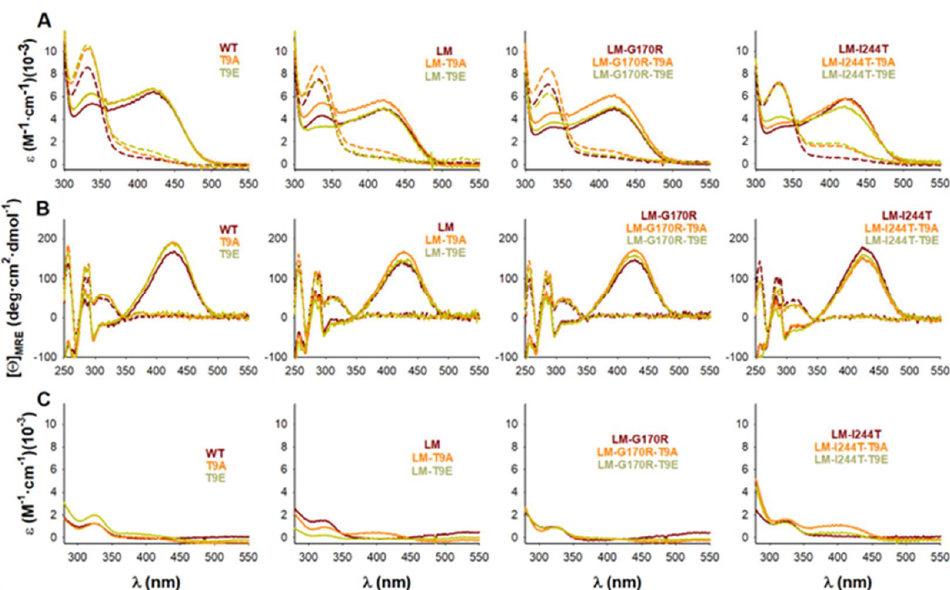
Figure 6. Transamination of bound PLP to PMP in the presence of L-Ala catalyzed by AGT variants (WT, LM, LM-G170R, and LM-I244T) in the absence or presence of the T9A or T9E mutations. ( A , B ) Near-UV/visible absorption ( A ) and near-UV CD ( B ) spectra of holo-AGT variants before (solid lines) and after (dashed lines) addition of 100 mM L-Ala. ( C ) Near-UV/visible absorption spectra upon filtration of the reaction mixture (dashed lines in panel A ) showing the release of PMP from the its tight complex with AGT variants.